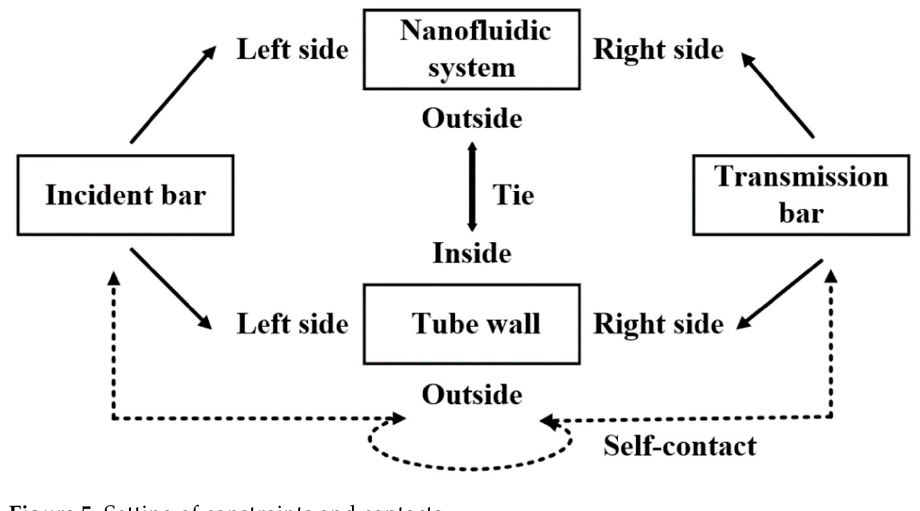
Figure 4. Stress–time curve of empty tube experiment and simulation.